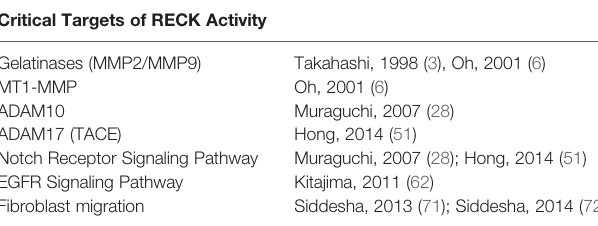
TABLE 1 | Major targets of RECK